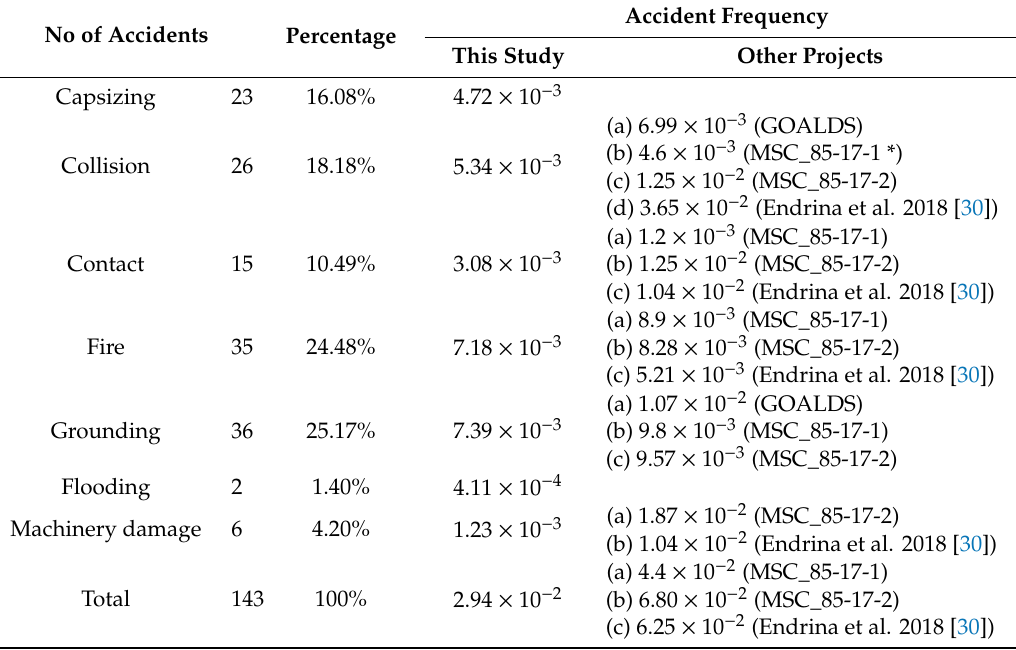
Table 12. Number of incidents and frequencies for global passenger ship